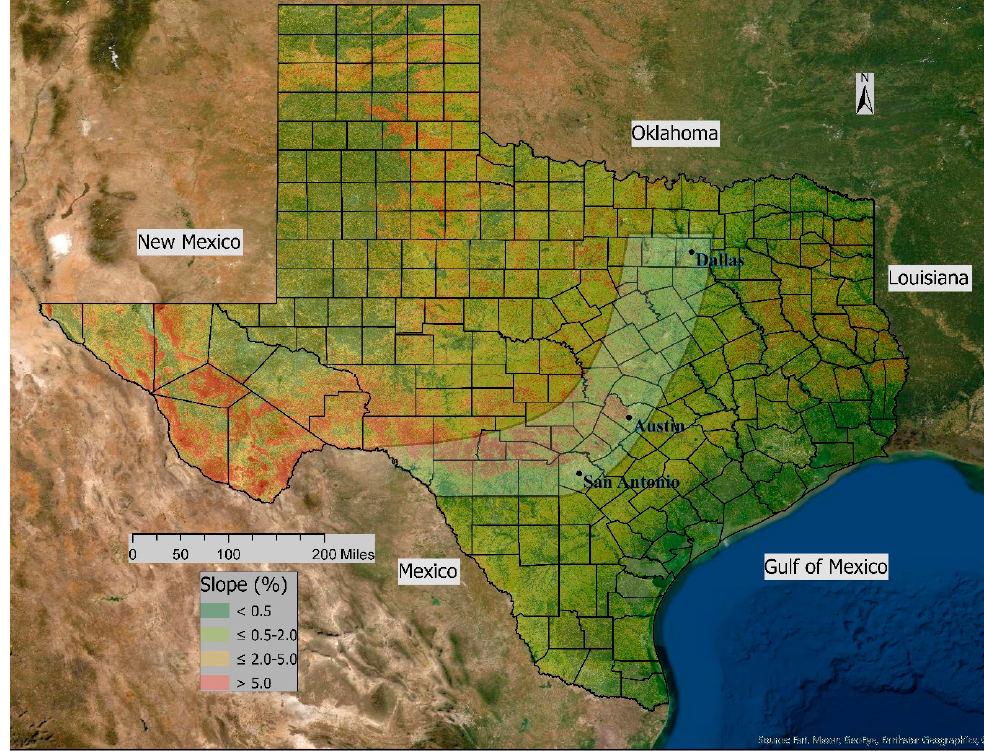
Figure 1. The Flash Flood Alley with slopes shown in the background (steepest slopes are red to orange).